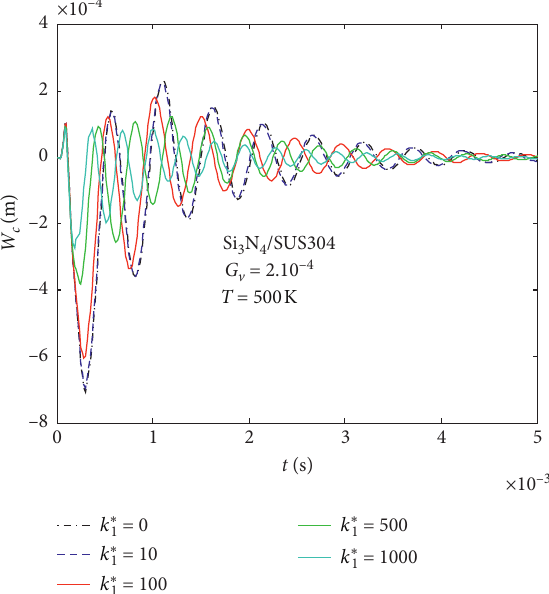
c on n , Si 3 N 4 /SUS304, SSSS,